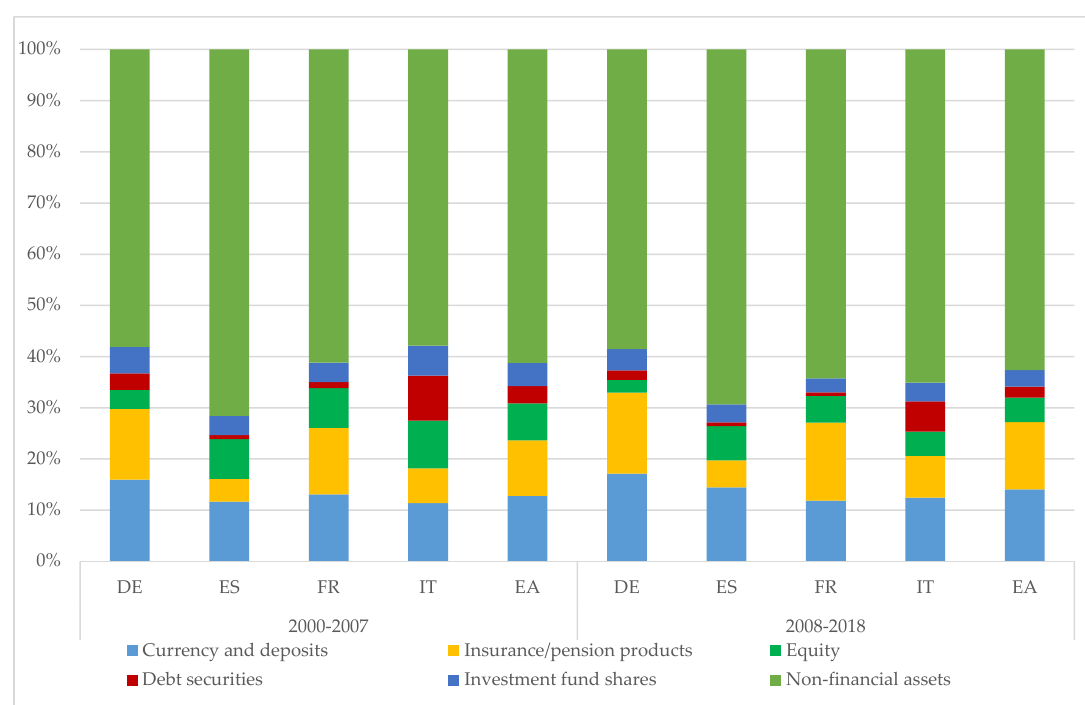
Figure 5. Euro area household portfolio structure. Note: DE: Germany; ES: Spain; FR: France; IT: Italy; EA: euro area. Source: authors’ calculations based on ECB, Eurostat, OECD, Thomson Reuters.